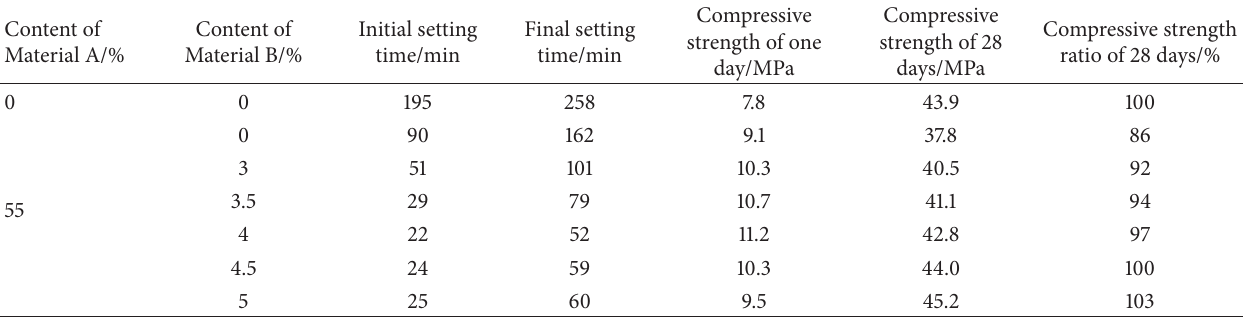
Table 7: Experimental results of combination of Materials A and B.